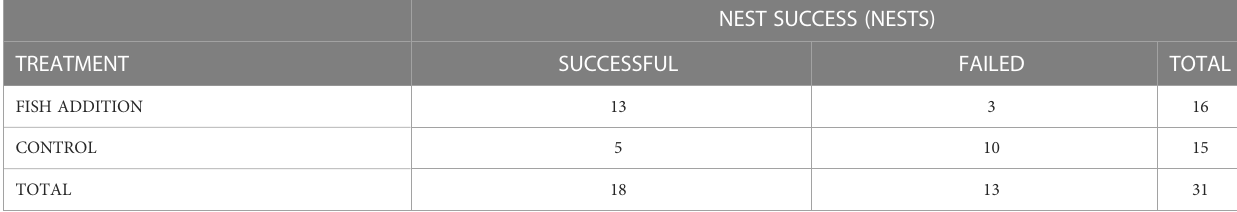
TABLE 1 Two-way contingency table used for the Pearson ’ s Chi-squared analysis that summarizes the relationship between treatment types and nest success during the 2021 osprey breeding season in the lower Chesapeake Bay, VA, USA ( c 2 = 5.5, df = 1, P = 0.02).